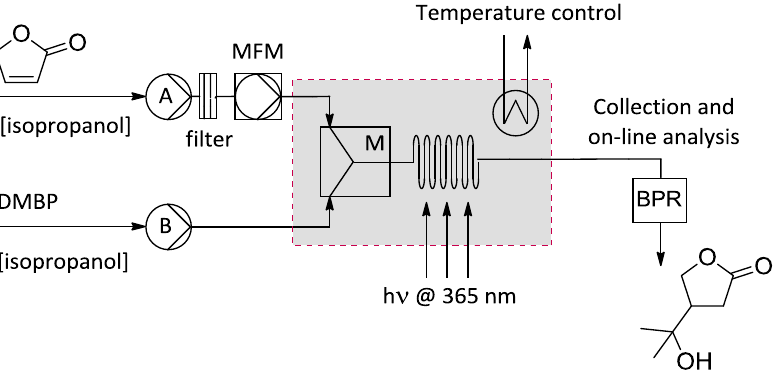
Figure 6. Schematic setup for the photochemical oxidation of